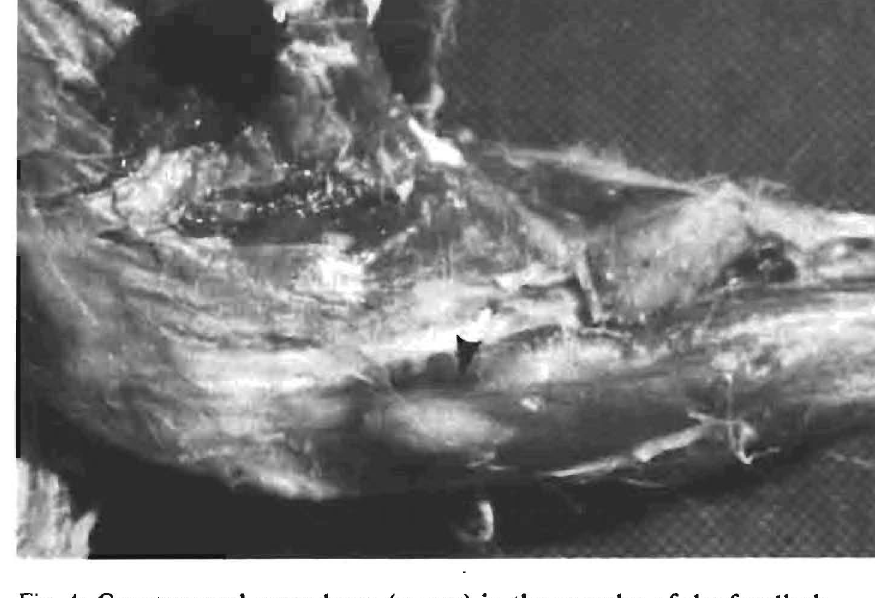
Fig. 4: Cryptococcal granuloma (arrow) in the muscles of the forelimb